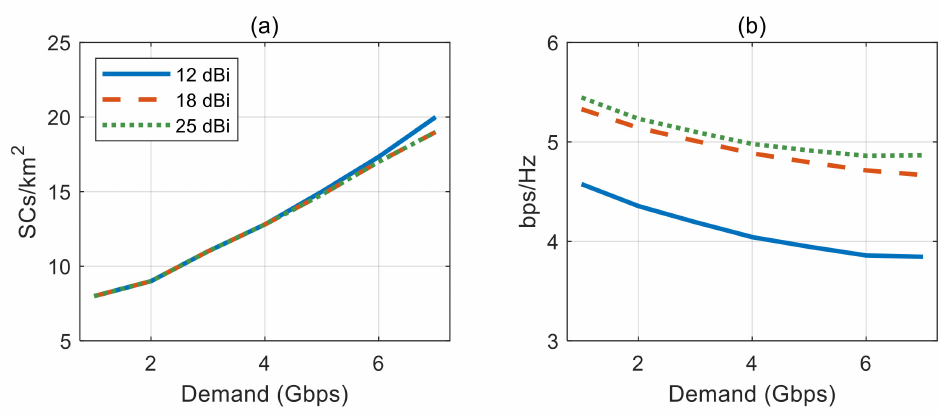
Figure 3. Evaluation in terms of number of SCs (#SCs) and spectral e ffi ciency in the BH network for di ff erent values of the antenna gain. ( a ) #SCs; ( b ) BH spectral e ffi ciency.